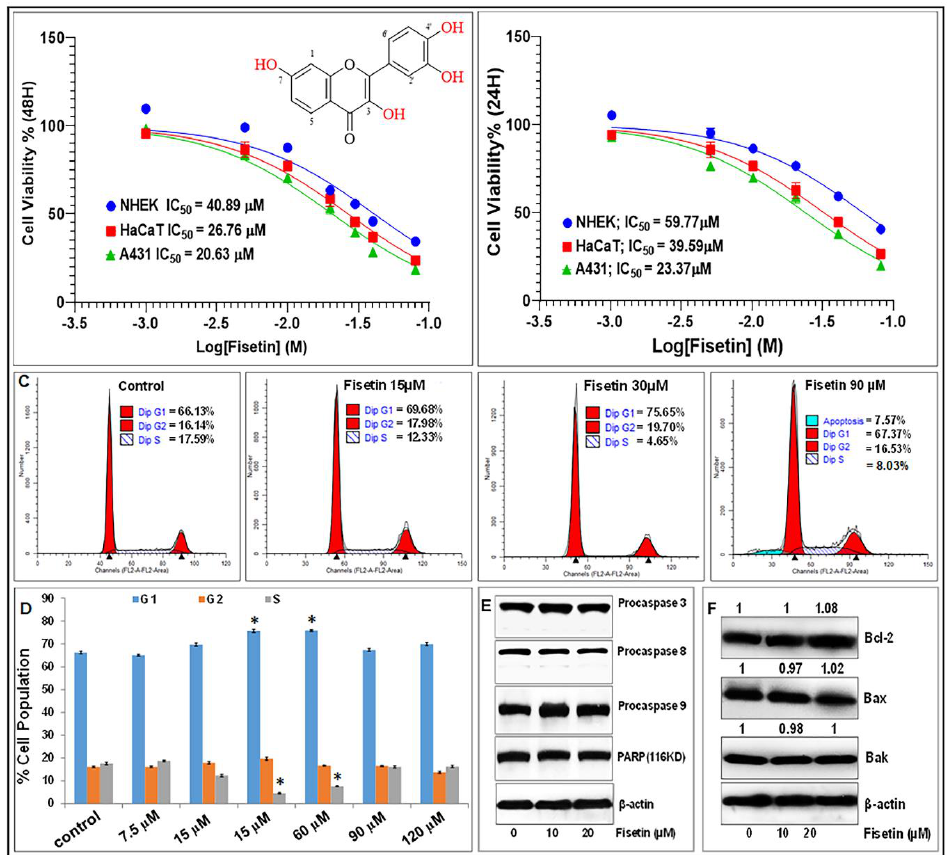
Figure 1. Fisetin at low doses (< 20 µM) does not significantly affect primary normal human epidermal keratinocyte (NHEK) growth and viability and does not induce apoptosis. ( A / B ) Relative number of viable NHEK, immortalized keratinocytes (HaCaT), and A431 cancer cells treated with or without fisetin (1 – 80 µM) for 24 h ( A ) and 48 h as determined by MTT assay. Mean of percentage viability of NHEK, HaCaT, and A431 cell lines plotted against the indicated doses of fisetin. Experiments were performed three times with each concentration done in octuplicate wells, and the IC 50 values calculated from these plots are shown. ( C ) Effects of fisetin on the percentage of cells population in